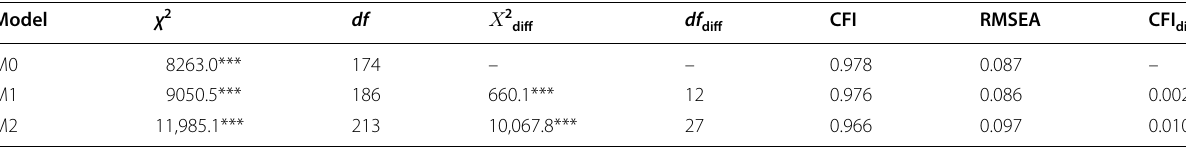
*** p < 0.001. Χ 2 diff is the Satorra and Bentler (2001) scaled Chi-square difference statistic. M0 model